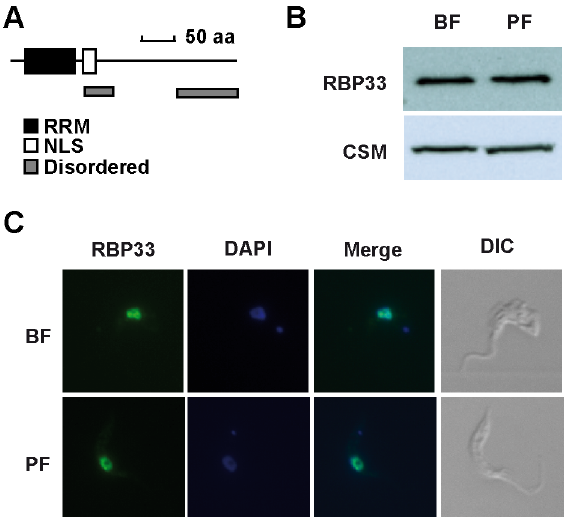
Figure 1. Expression and subcellular localization of RBP33 in bloodstream and procyclic trypanosomes. (A) Schematic diagram of T. brucei RBP33. An anti-RBP33 antiserum was used to detect the protein by (B) western blot analysis of total cell extracts or (C) immunofluorescence assays. CSM protein [39] was included as loading control, and DAPI was used to stain nuclei.